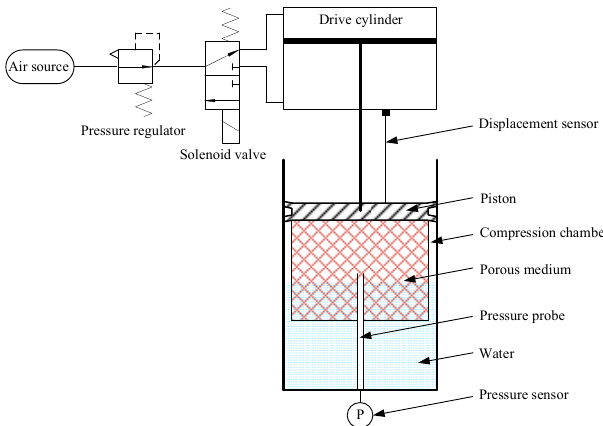
Figure 5. Schematic of the experimental platform.